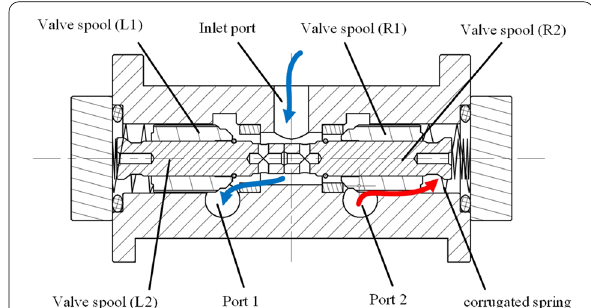
Figure 5 Structure diagram of FMV